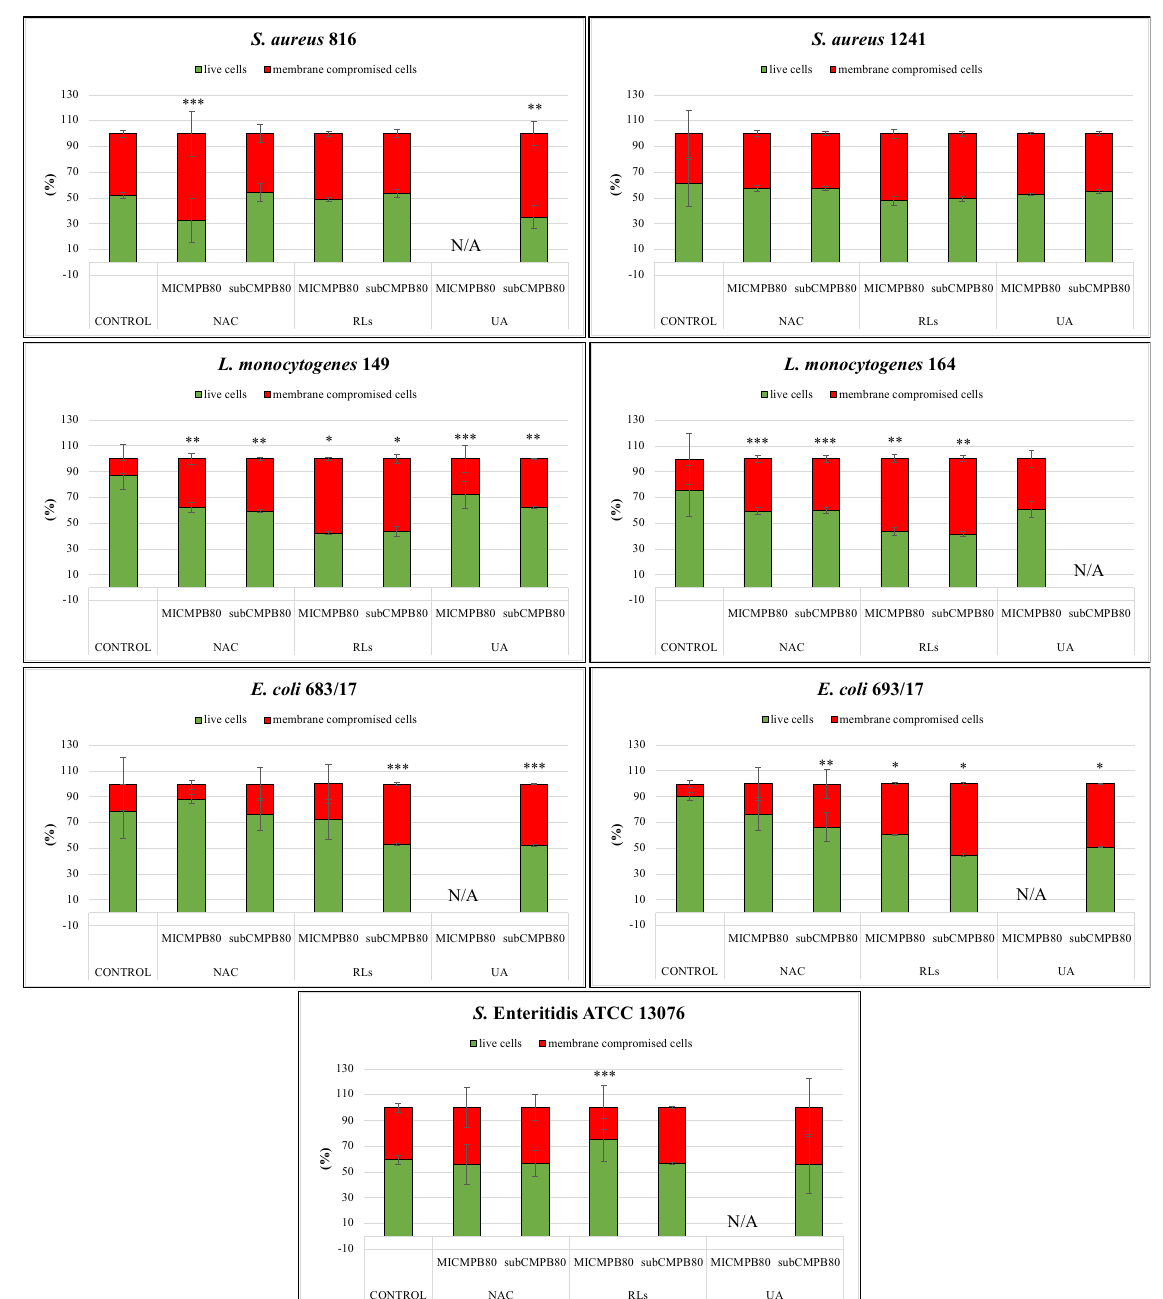
Figure 5. Biofilm Removal: Ratios of live (green) and membrane−compromised cells (red) of individual organisms ( Staphylococcus aureus 816, 1241, Listeria monocytogenes 149, 164, E. coli 683/17, 693/17, and Salmonella Enteritidis ATCC 13076) after 20 h of treatment with N−acetyl−L−cysteine (NAC), rhamnolipids (RLs), and usnic acid (UA). Columns represent the mean and standard deviation of at least four independent technical replicates. For some strains, the minimum inhibitory and subinhibitory concentrations could not be established; thus, they were not involved in the analysis. N/A marks concentration was not applied. * marks p < 0.001, ** marks p < 0.01, *** marks p < 0.05, which are statistically significant differences in proportion of membrane−compromised cells comparing to the control.